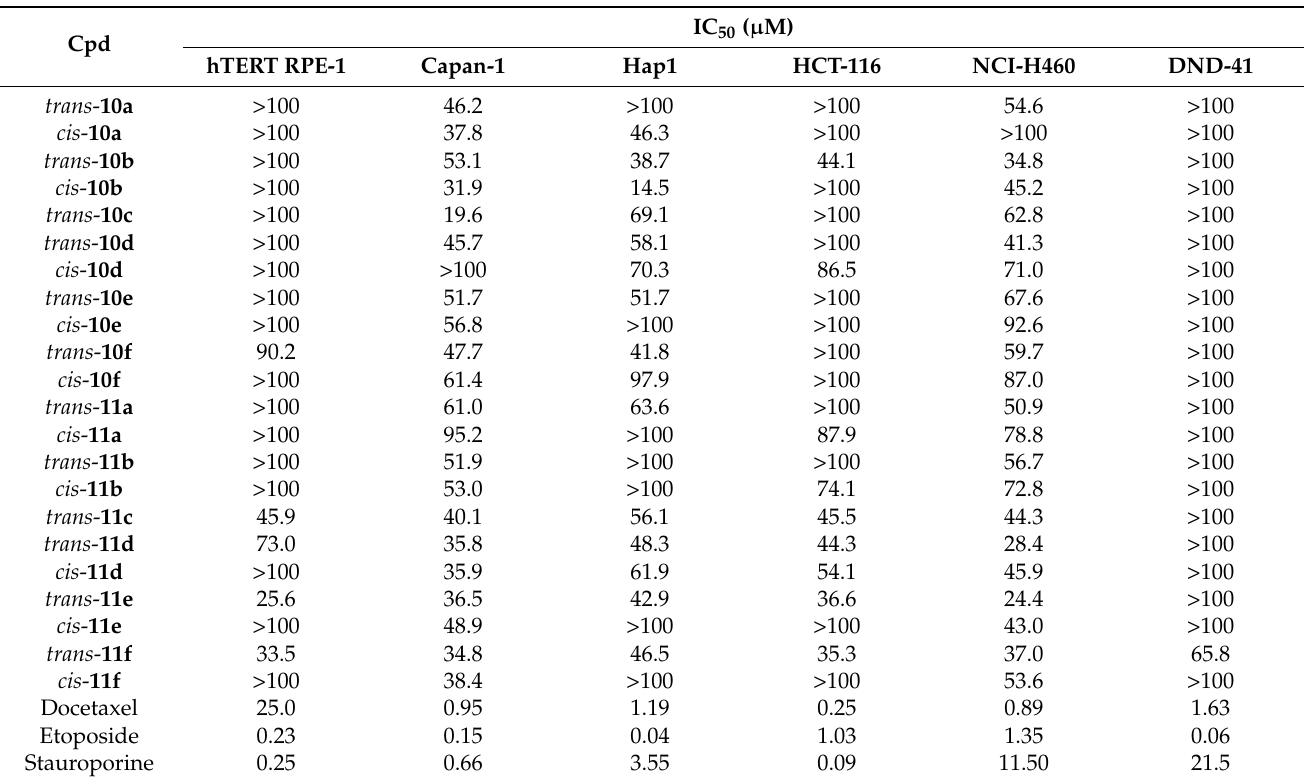
Table 4. Inhibitory effect of azetidinones cis - 10 / trans - 10 and cis - 11 / trans - 11 against the proliferation of cancerous cells.